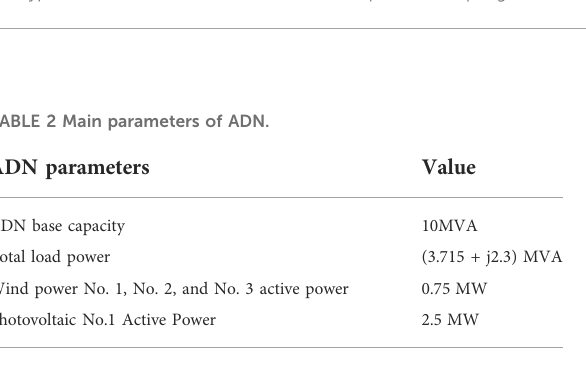
FIGURE 2 Typical diurnal curves of load, wind and PV power. (A) Spring. (B) Summer. (C) Autumn. (D) Winter.